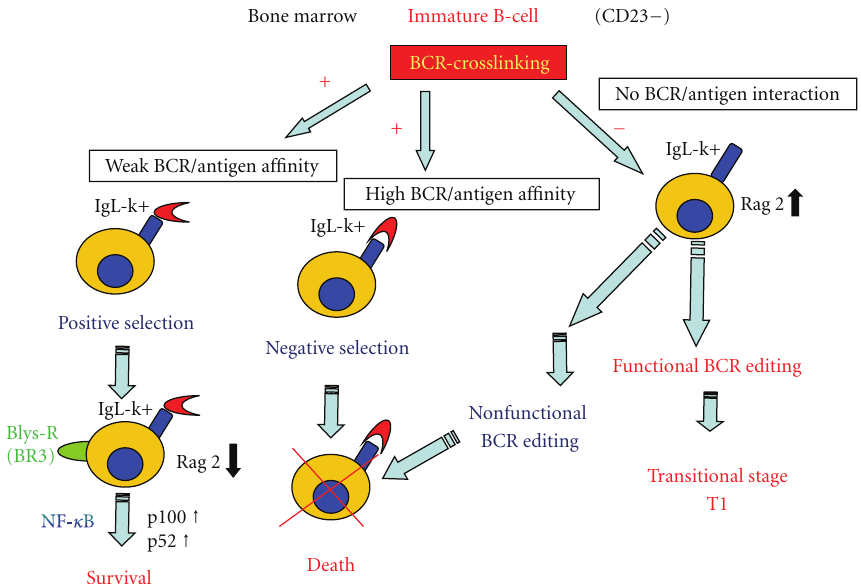
Figure 2: A model of BCR/BLyS interaction of immature B-cells to transitional B-cells. In bone marrow, weak BCR linkage of immature B-cells induces BLyS-receptor expression and a down-expression of RAG-2, an enzyme involved in BCR editing. In addition, immature B-cells can be rescued from the negative selection of the BCR signaling apoptotic pathway. After a functional (but not strong self-reactive) BCR editing is accomplished. In case of high BLyS level, some weak self-reactive B-cells (weak BCR/antigen a ffi nity) can be developed into T-transitional immature B-cell